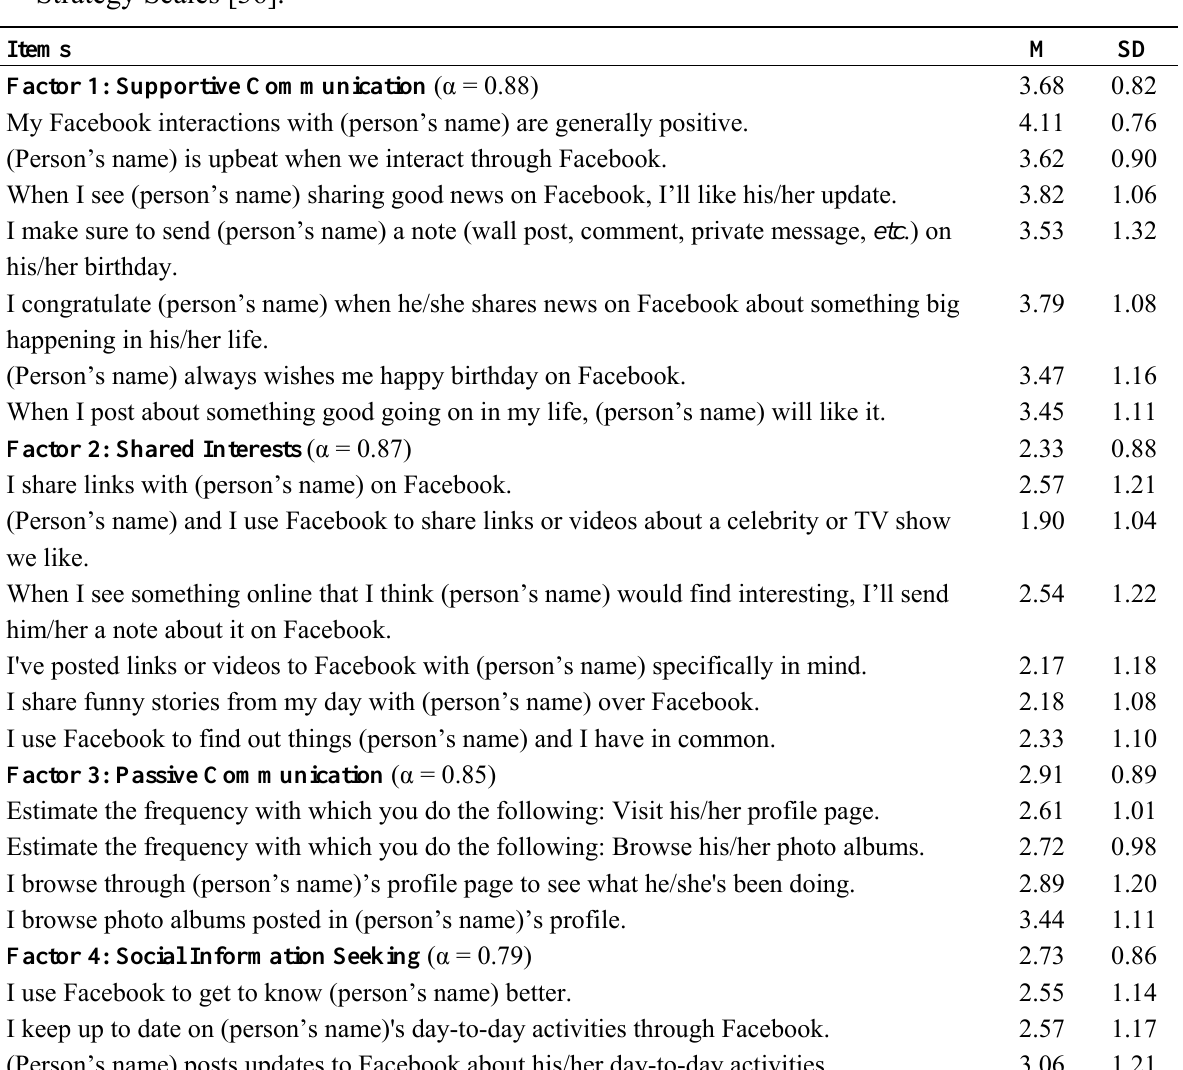
Table 3. Items, Means, and Standard Deviations for Facebook Relationship Maintenance Strategy Scales